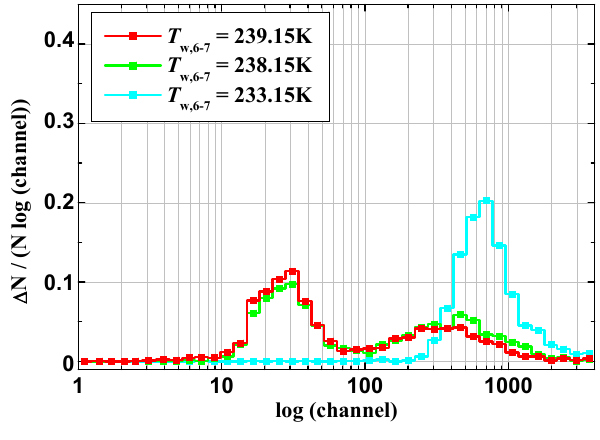
Fig. 4. Measured size distributions for one-section measurements at three different wall temperatures. The normalized number is plot- ted versus the logarithm of WELAS® size channel. The narrow modes are caused by supercooled liquid water droplets, while the tails originate from ice crystals.